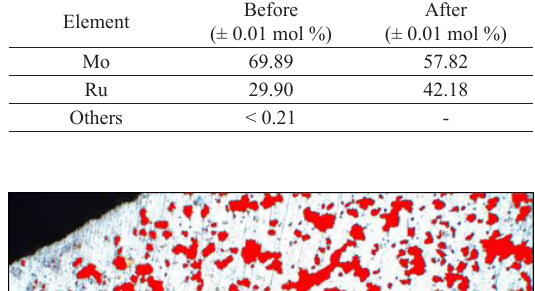
Figure 8. Arrangement of the sample holder with the cathode buttons.